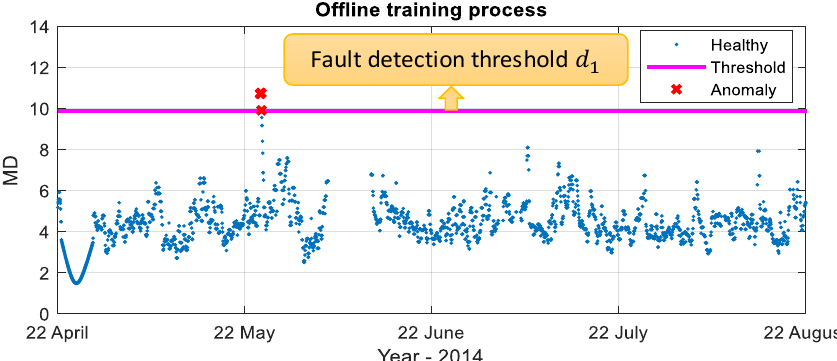
Figure 14. Offline fault detection model trained for an industrial compressor from 22 April to 22 August 2014 by SAE. (Blue points: healthy data; red points: anomalies; magenta line: reference MD thresholds).